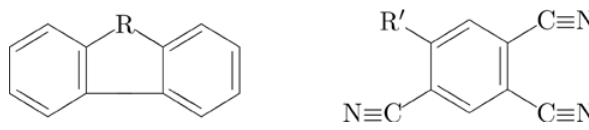
Figure 1. Left, N-Methyl Carbazole radical R denotes N • ⊕ –CH 3 abbreviated as NMCZ • ⊕ and right Tetra Cyano Benzene radical with R’ denoting C ≡ N • ⊖ , abbreviated as TCNB • ⊖ . In fact, the posi- tion of ⊕ in the NMCZ radical and ⊖ in the TCNB radical isunk-